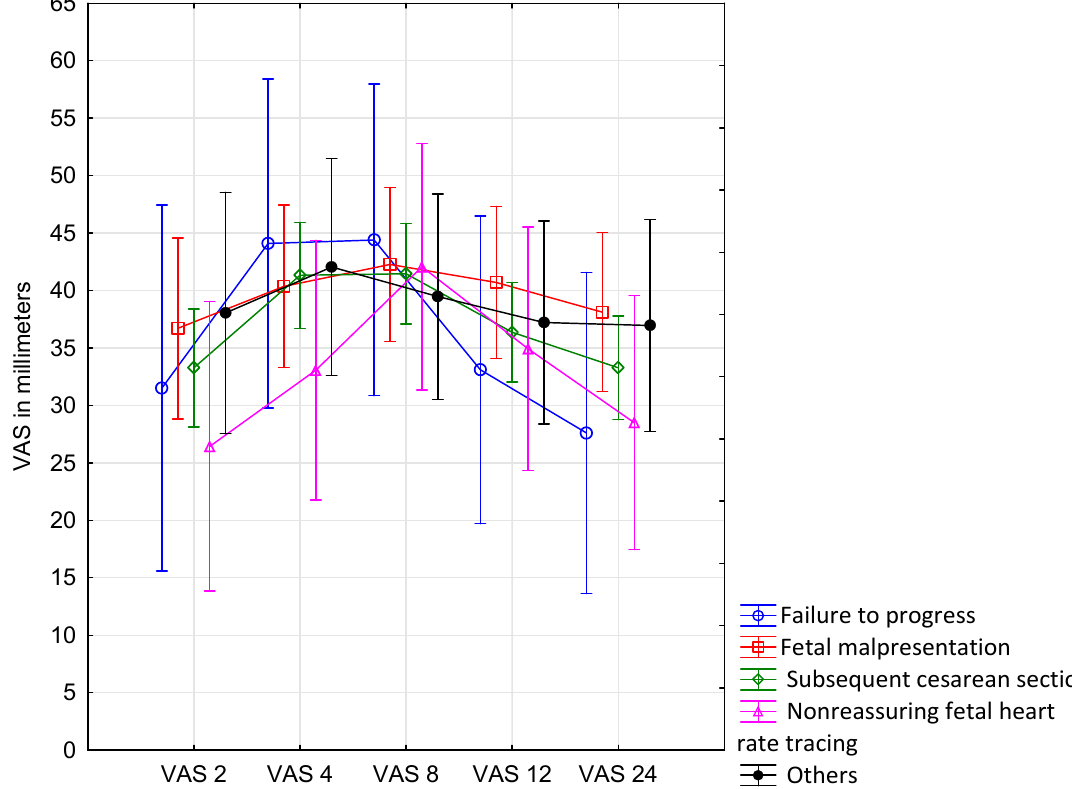
Figure 5. Postoperative pain severity during the first 24 h after the surgery according to indications for cesarean section. The plots represent VAS results according to the type of indication for cesarean section (without the division to the study groups). The results from each measurement are shown as a mean. Vertical bars denote 0.95 confidence intervals (CI). Table 5. Postoperative pain severity during the first 24 h after the surgery according to indications for cesarean section and type of regional analgesia.